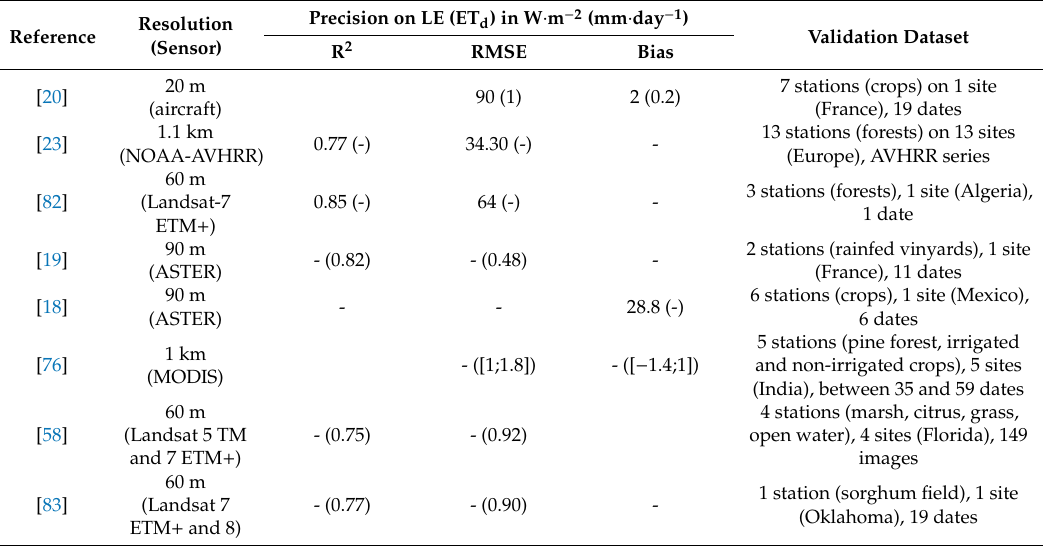
Table A1. Non-exhaustive review of evaluation studies of S-SEBI-based estimations of instantaneous LE and / or daily ET